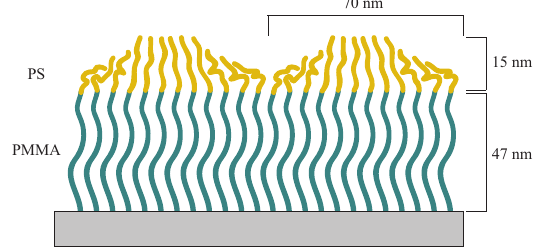
Figure 8. Schematic sketch of PMMA- b -PS diblock copolymer brushes in dry state. PS chains accumulate on top of PMMA brushes, to minimize their contact with PMMA and air. This shape is inferred by the layer thickness of 15nm of the PS block and the PS domain diameter of